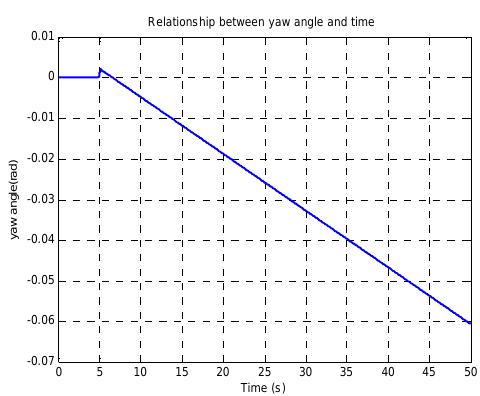
Fig.11. Comparison of real path and reference path on straight-line running